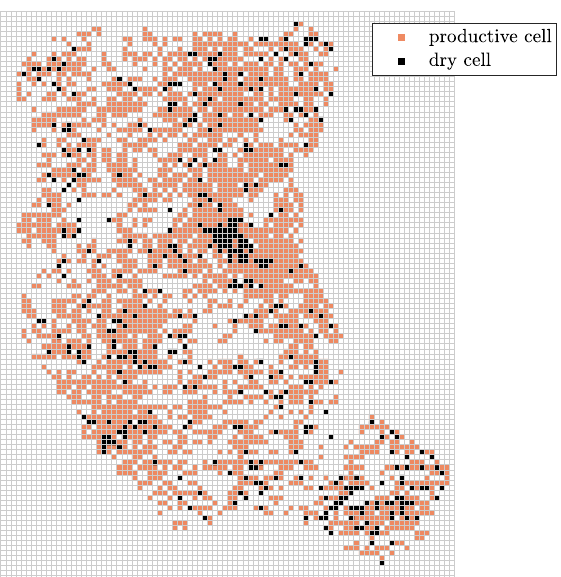
Figure 13. An example of probability of success in the Midland Wolfcamp Core. Each cell represents one square mile grid. The probability of success is defined as the number of productive cells (orange) divided by the total number of productive and dry cells (orange + black).